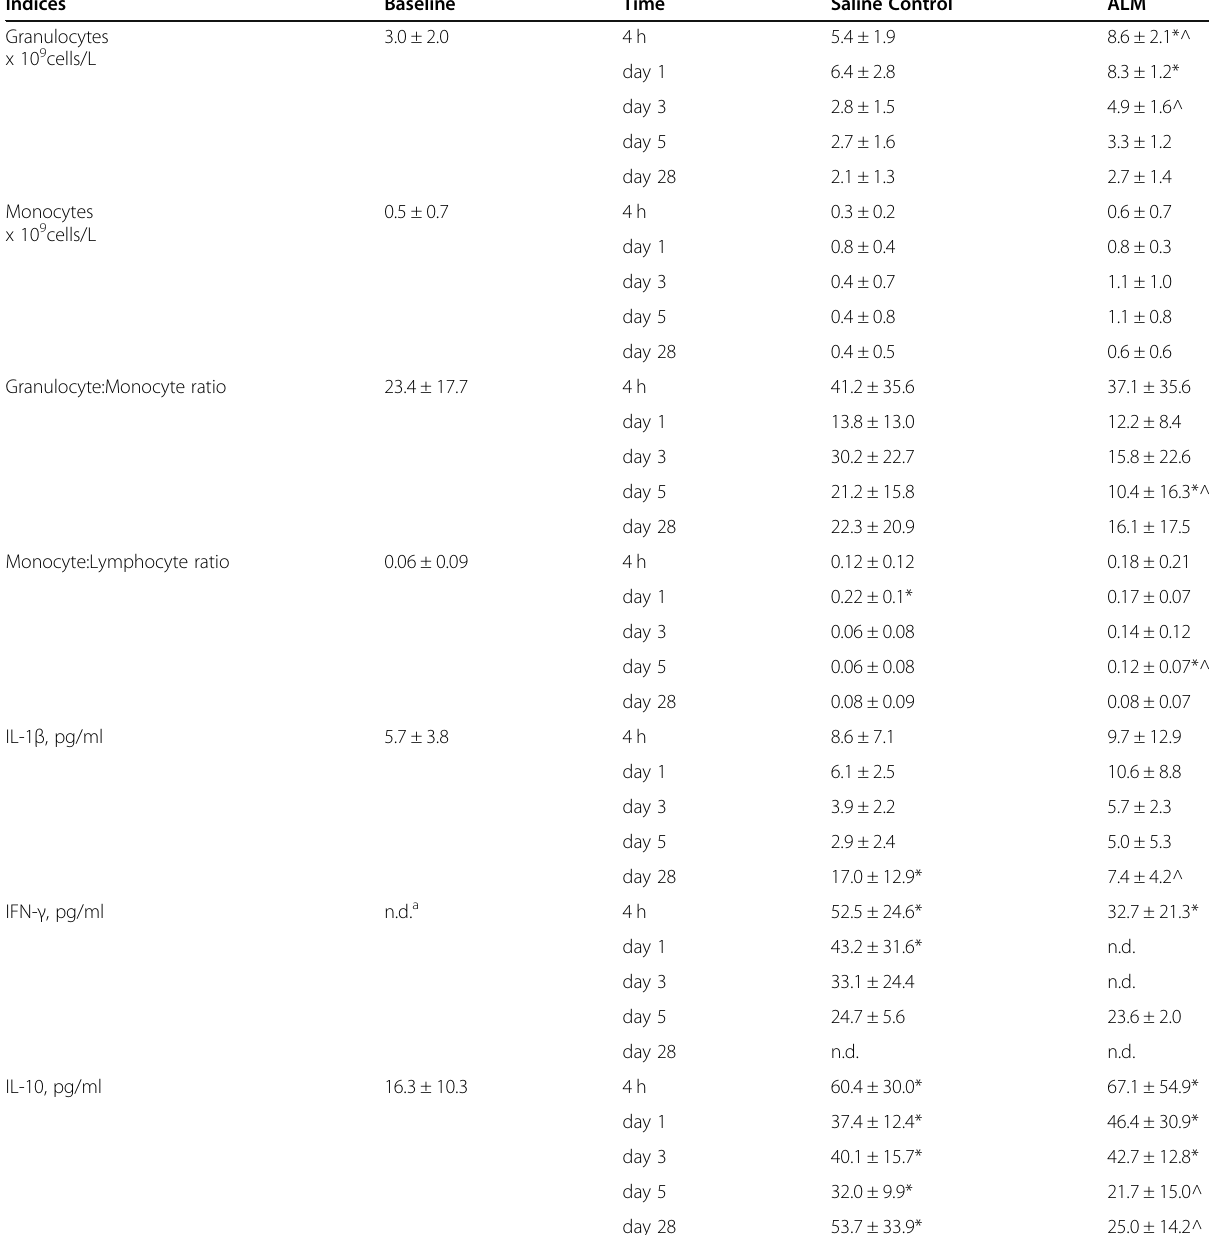
Table 1 Hematology and systemic inflammatory responses